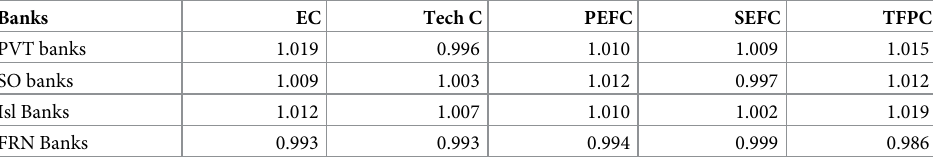
Table 3. Productivity